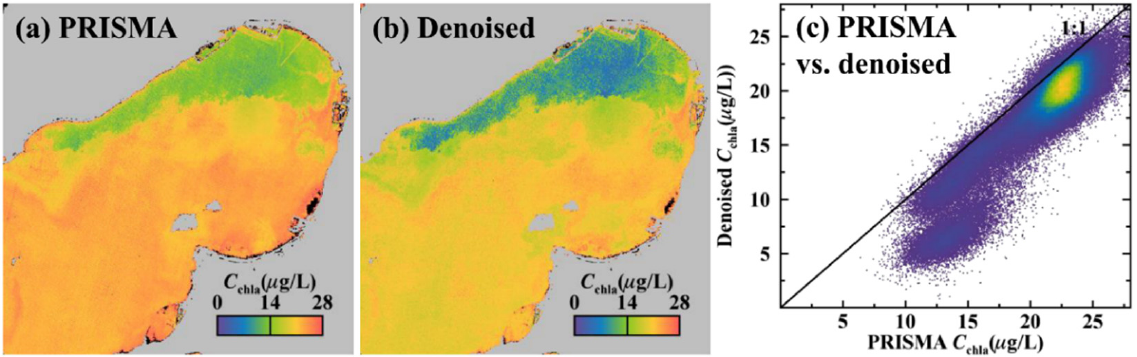
Figure 11. C chla maps yielded from ( a ) PRISMA and ( b ) denoised images and ( c ) their scatter plot.